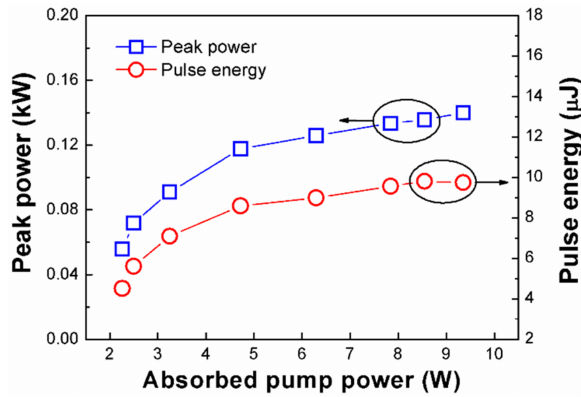
Figure 4. Pulse energy and the corresponding peak power of the Q-switched laser versus the absorbed pump power.